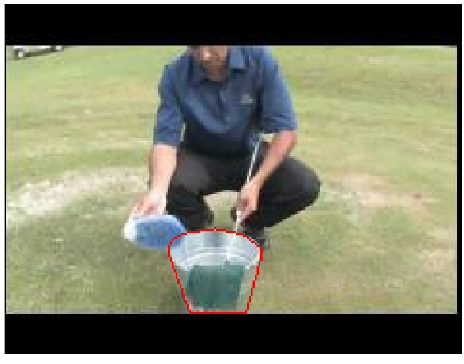
Figure 5. Bounding polygon (marked) for pail of water in test image